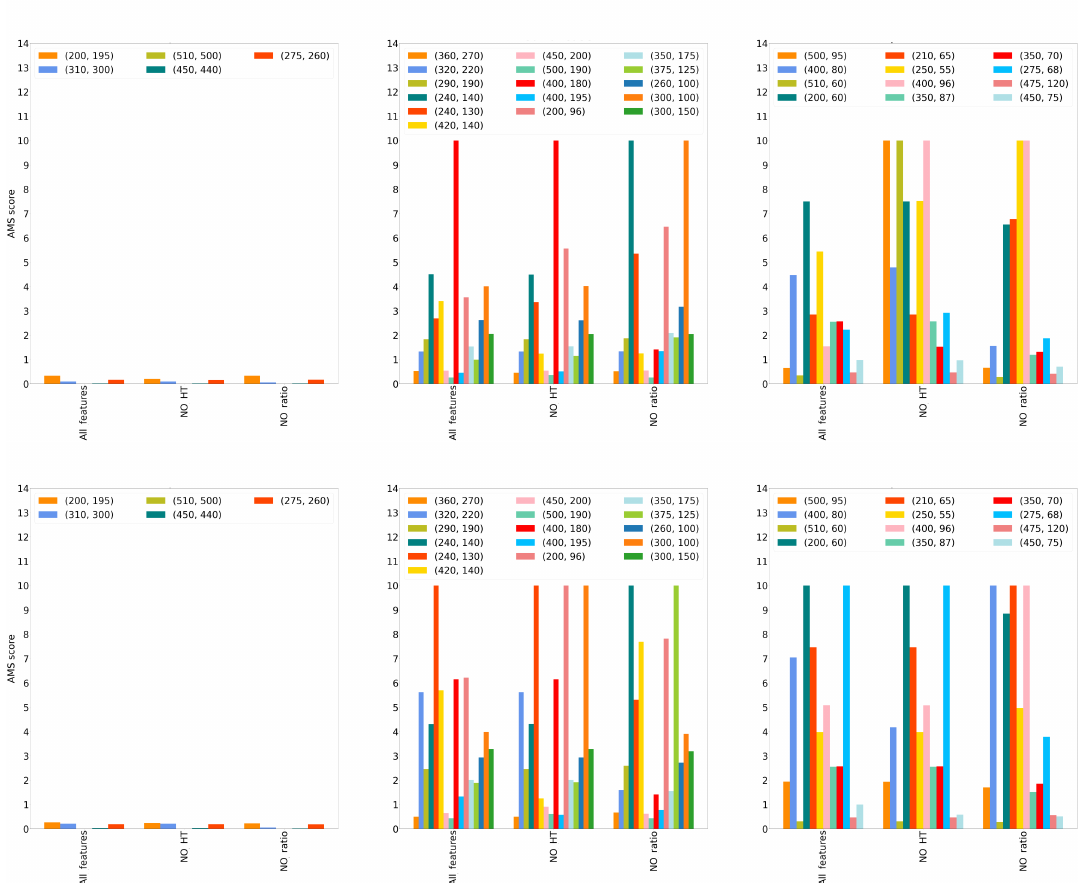
Figure 5 . The top figures show the ams score of the model when using the auc metric (top) and the F score (bottom) to train the model, with compressed , neutral and separated scenarios from left to right. The masses specific to the benchmark are labelled ( m ˜ µ , m ˜ χ